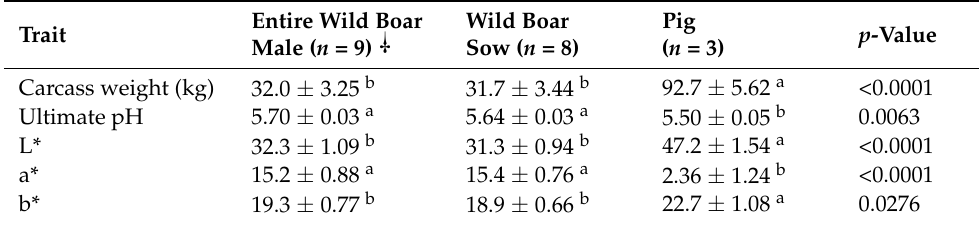
Table 1. Technological quality traits for wild boar and pig. Data presented as means and standard deviation.